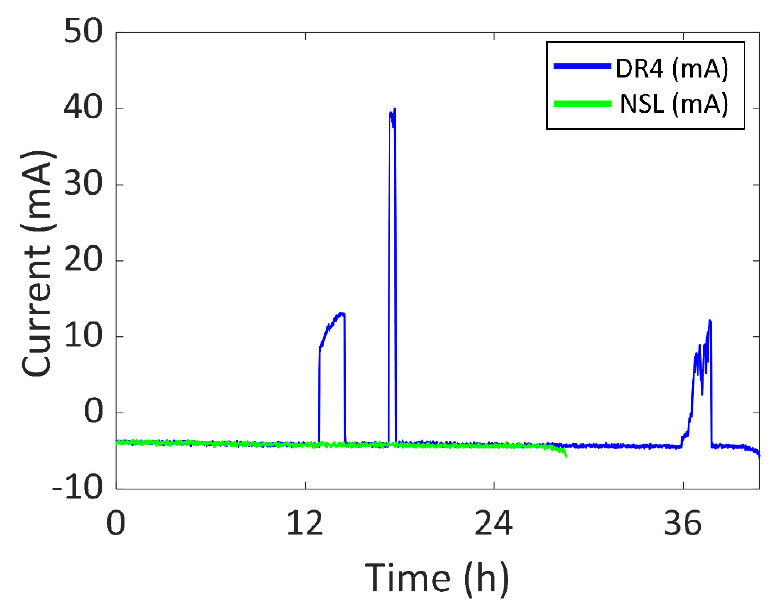
18 of 22 Figure 15. Battery current vs. time of DR3 and NSL experiments. In Figure 16, the battery current vs. time of DR4 compared to NSL is presented in blue and green respectively. The experiment started at 20:23 of day one and ended at 13:13